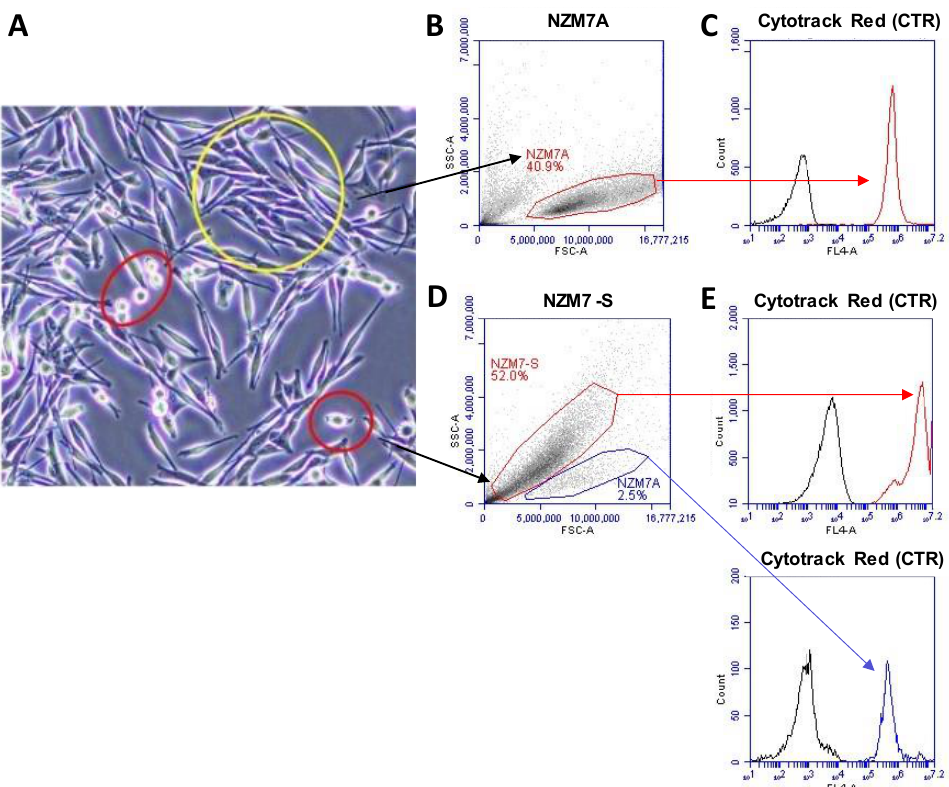
Figure 1. NZM7 imaging and gating strategies. ( A ) NZM7 cell line in culture. Yellow circle shows NZM7A, red circles show NZM7-S. ( B , D ) Scatter profile of gated NZM7A and NZM7-S according to density in y -axis (SSC-A) and size in x -axis (FSC-A). ( C , E-top ) CTR fluorescence (red) of the suspension population compared to the cells autofluorescence (black) as measured in channel FL4- 672/25 filter. ( E-bottom ) CTR fluorescence (blue) of the NZM7A population in the NZM7-S collection. Data show 1 representative experiment, which is from 3 independent experiments.